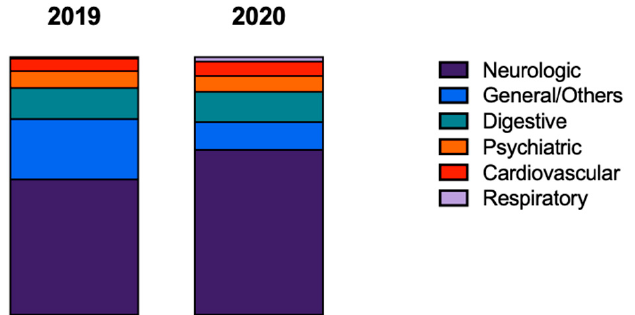
Figure 4. Characterization of the intoxication circumstances in the Algarve region in 2019 and 2020. Comparing 2019 and 2020, the distributions were as follows: intentional (43.47% vs. 51.19%), thera- peutic error (29.11% vs. 21.74%), accidental (25.74% vs. 25.39%), adverse reaction (1.03% vs. 0.84%), unknown (0.65% vs. 0.84%).